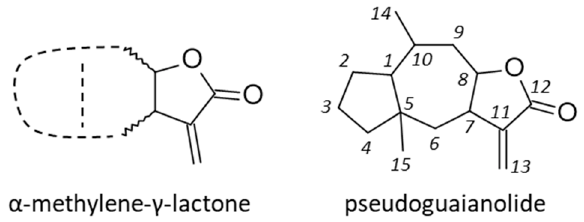
Figure 1. Structures of the α -methylene- γ -lactone unit and pseudoguaianolide core, present in britannin and related products. The numbering scheme is mentioned.